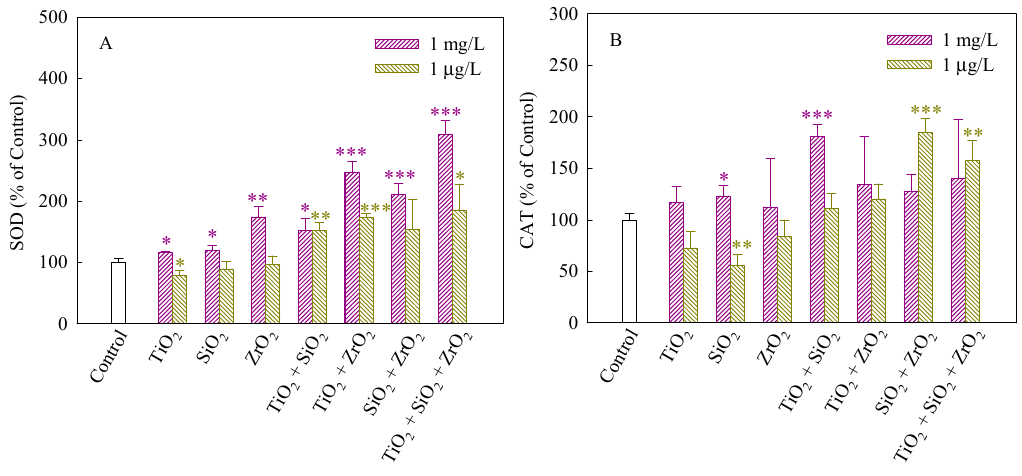
Figure 4. Activities of SOD ( A ) and CAT ( B ) in S. obliquus exposed to 1 mg/L and 1 μ g/L of NPs alone, 1 mg/L and 1 μ g/L of single NPs in binary combination and 1 mg/L and 1 μ g/L of single NPs in ternary combination. Statistical significance versus control group: * p < 0.05, ** p < 0.01 and *** p < 0.001.